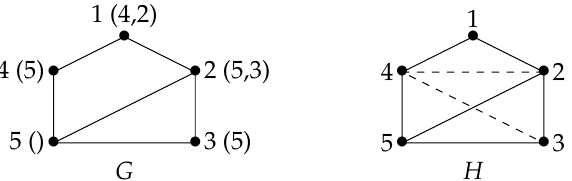
Figure 4. Lexicographic Breadth-First Search (LexBFS) on a non-chordal graph computes an ordering that is compatible with a simple moplex partition, but not with an